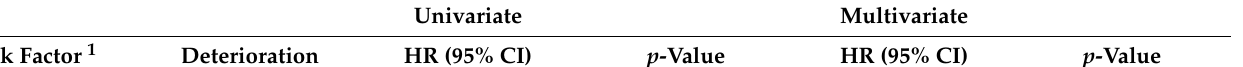
Table 5. Overall survival of age-adjusted hazard ratios for change QLQ C30 and QLQ CR38. Univariate